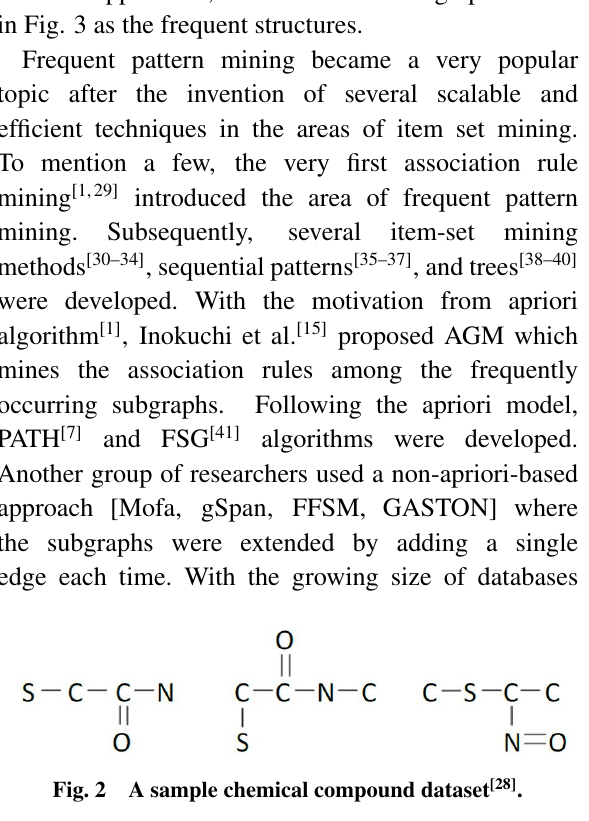
Fig. 2 A sample chemical compound dataset [28] .